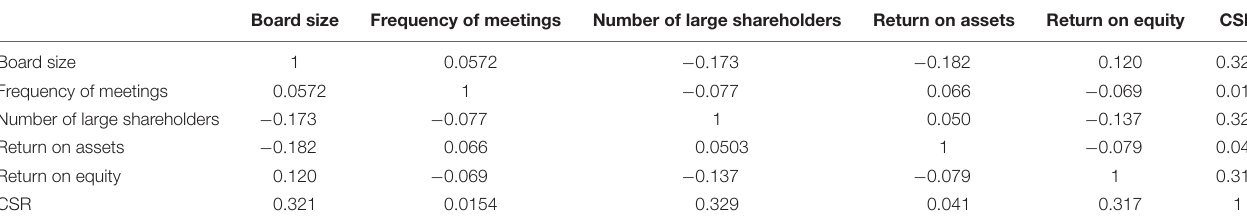
TABLE 3 | Correlation coefficient.